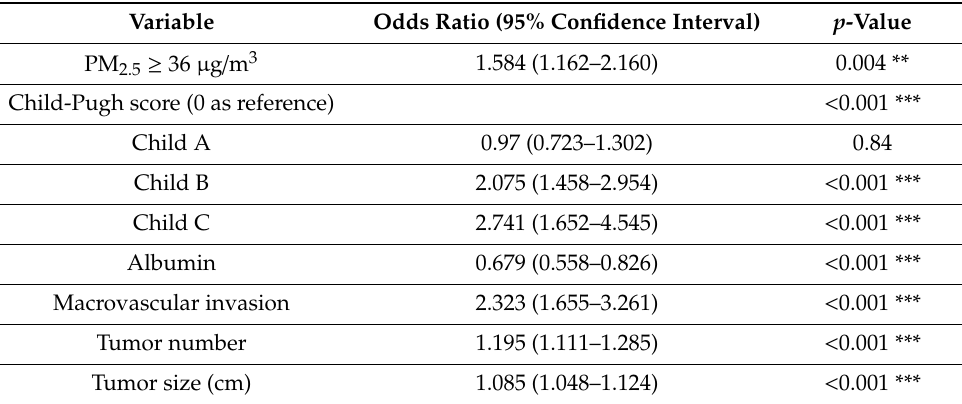
Table 4. Multivariate Cox regression analysis of mortality ( N = 1003).